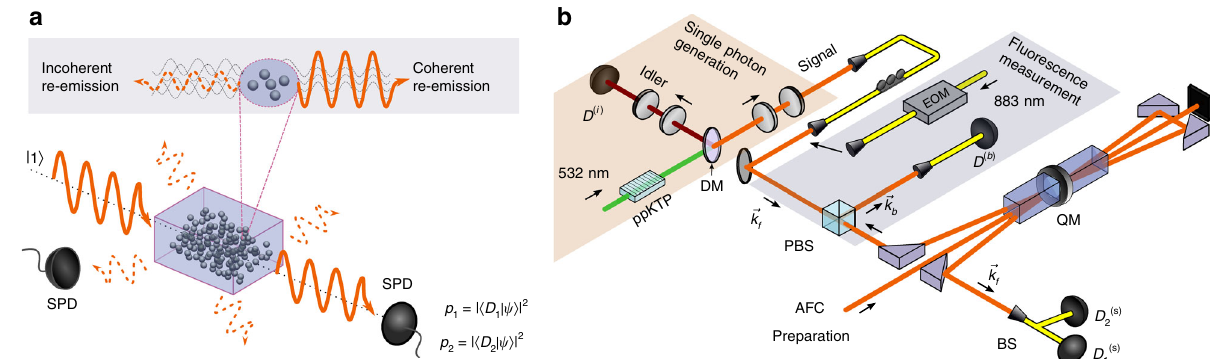
Fig. 1 Basic intuition and experimental setup. a When atoms spontaneously emit photons, phase coherence between the atoms leads to constructive interference and enhanced emission probability in a certain direction, measured by a single-photon detector (SPD). Emission in any other direction is incoherent and hence not enhanced. If this phase coherence is generated by absorbing a single photon, the atoms are necessarily entangled. b The experiment consists of the heralded single-photon source, the quantum memory (QM), the detection system in the forward mode k f and the fl uorescence measurement in the backward mode k b of the QM. The source is based on a spontaneous parametric down conversion process. A periodically poled KTP (ppKTP) waveguide is pumped by a monochromatic laser at 532 nm wavelength which leads to the generation of photon pairs. They contain signal (idler) photons at 883 nm (1338 nm) wavelength spatially separated by a dichroic mirror (DM). The detection of the idler photon ( D (i) ) heralds the presence of the signal photon in a well de fi ned spectral, temporal and polarization mode. The heralded single photon is absorbed by the quantum memory which is based on two Nd 3+ :Y 2 SiO 5 crystals. A double-pass con fi guration is used to enhance the absorption process. To estimate p 1 and p 2 , the one-photon and two-photon probabilities from the re-emission process are measured in the forward direction, k f , using a fi ber-based 50/50 beamsplitter (BS) and two SPDs D ð s Þ and D ð s Þ . In order to measure the number of atoms N , the single-photon source is replaced by a bright coherent state created using an 1 2 electro-optical modulator (EOM). This increases re-emission intensities in forward and backward direction. The backward direction is measured by placing a polarization beamsplitter (PBS) in the input mode of the memory and using a SPD D